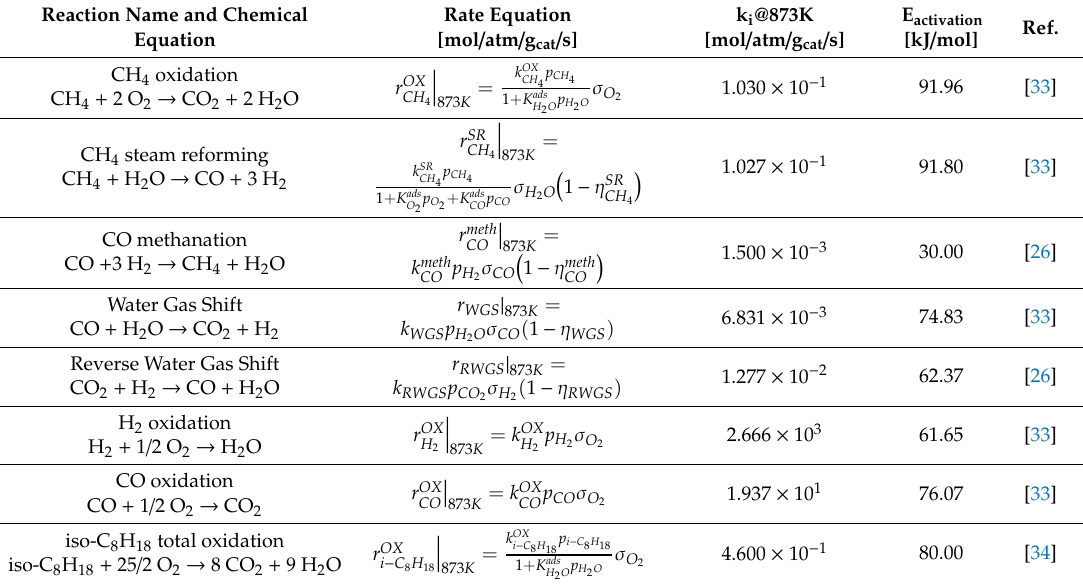
Table 5. Heterogeneous reaction mechanism for iso-octane CPO [30,35,36]. Reaction Name and Chemical